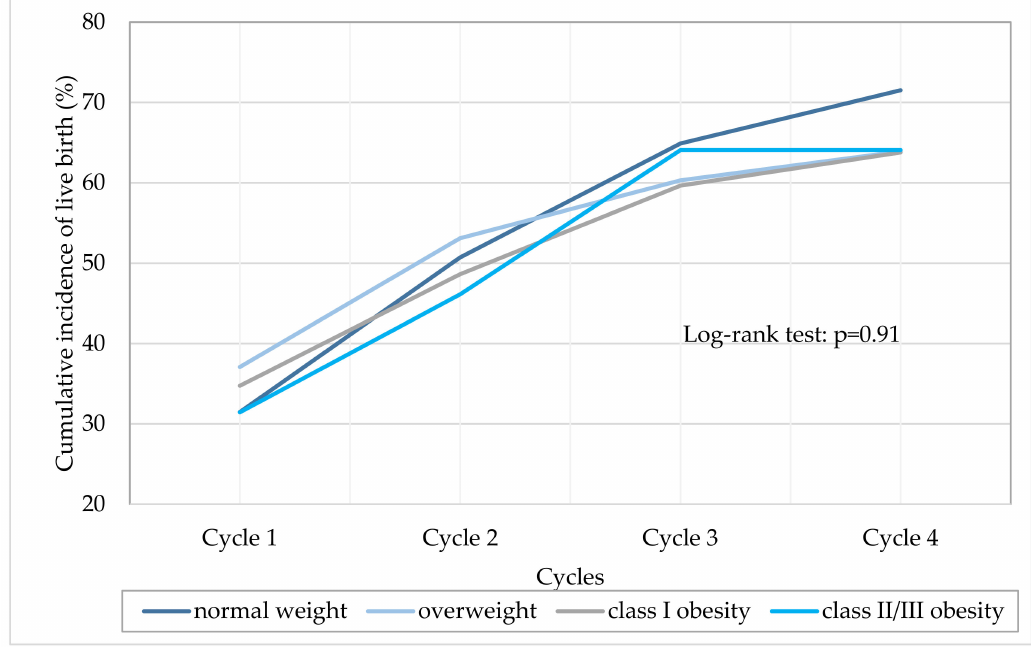
Figure 3. Cumulative incidence of live birth by BMI